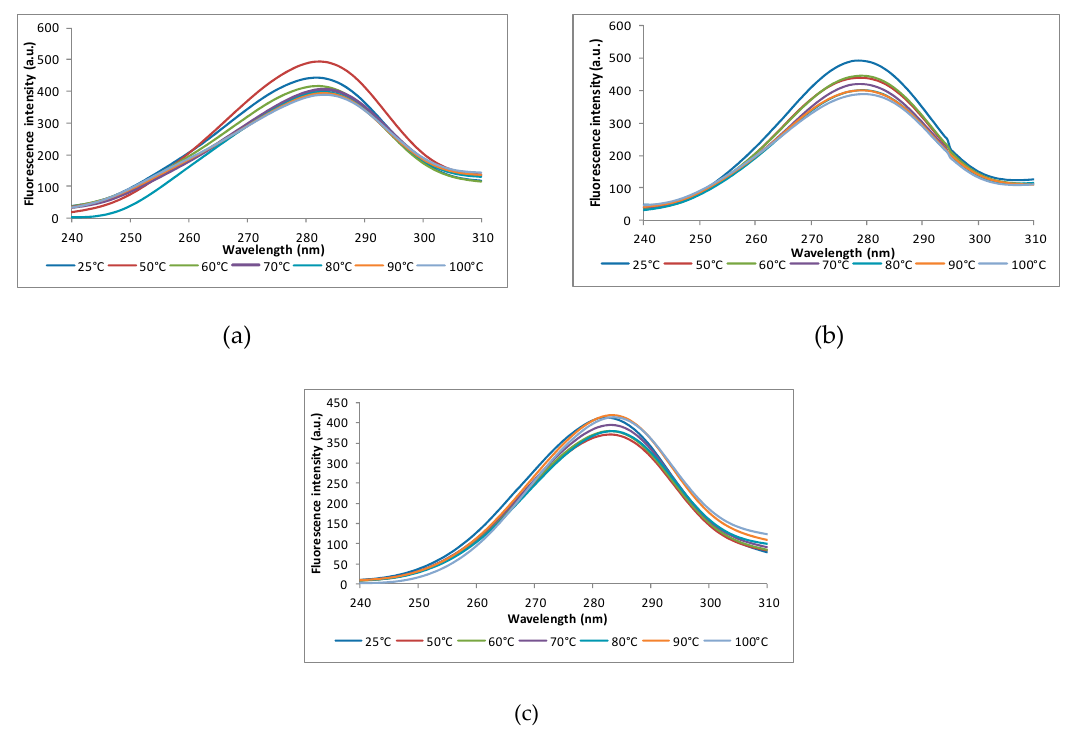
Figure 3. Synchronous fluorescence spectra of the rice proteins at Δλ = 60 nm at different temperatures values: ( a ) albumins, ( b ) globulins, and ( c ) glutenins. Three independent tests were carried out in each case and SD was lower than 3.5%.